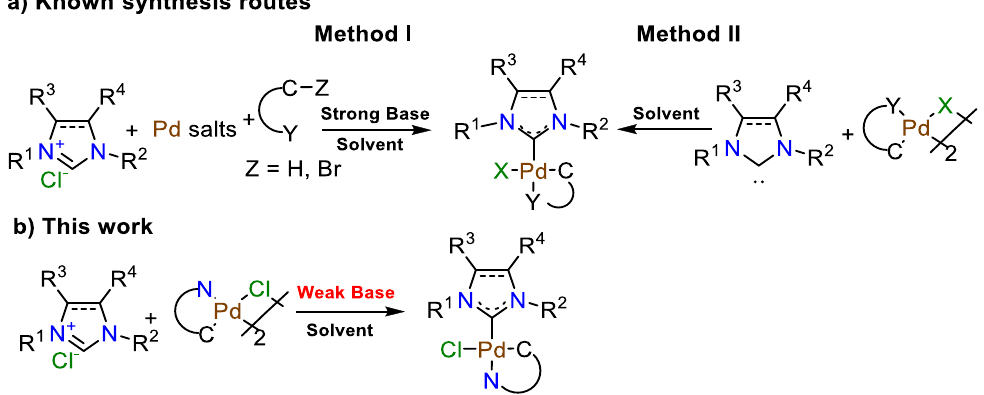
Figure 2. ( a ) Design strategies/synthetic routes to NHC – C , N -Pdcycles; ( b ) Synthesis for NHC- C , N - Pdcycles using the weak base route.